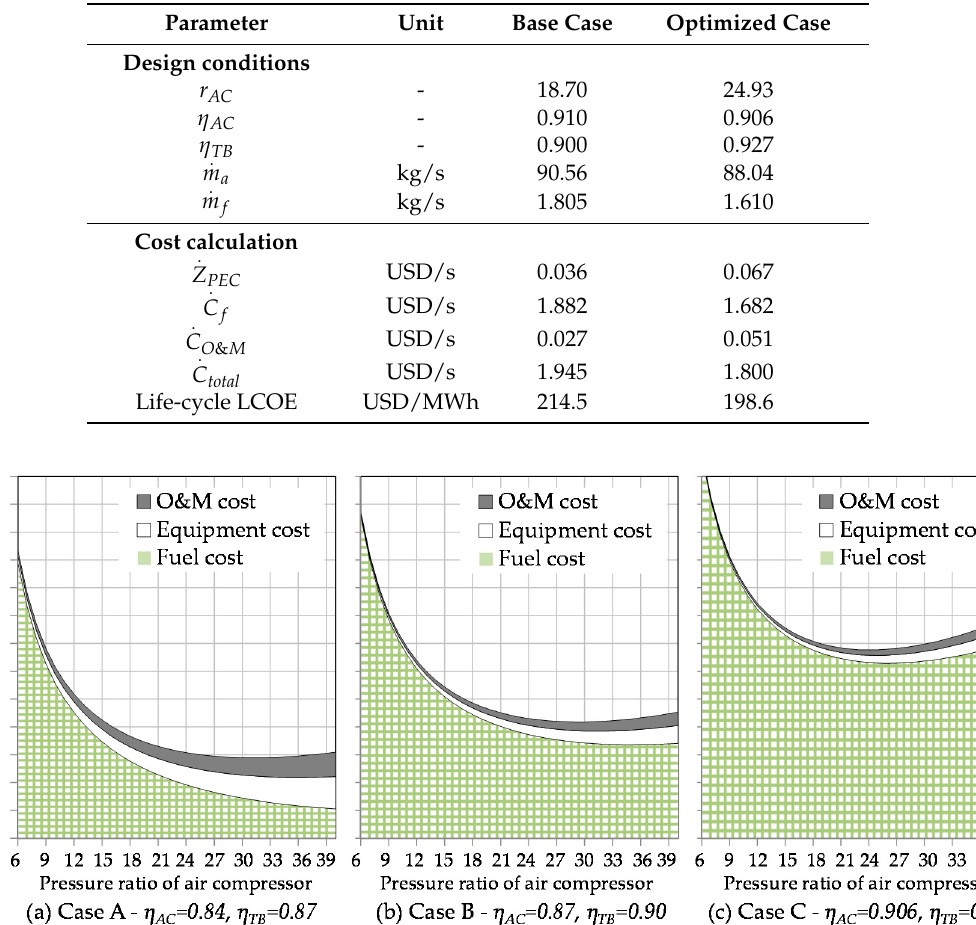
Figure 4. Cost rates of gas turbine simple cycle with respect to change of compressor pressure ratio for various compressor and turbine efficiencies: ( a ) isentropic efficiencies of air compressor and turbine were assumed to be 84% and 87%, respectively; ( b ) 87% and 90%; ( c ) 90.6% and 92.8%.